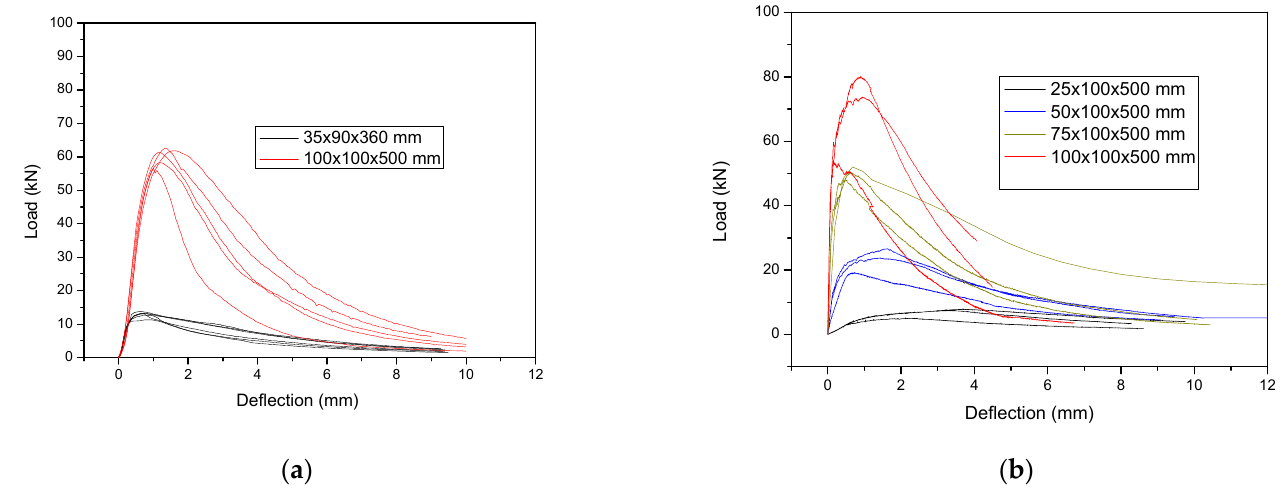
Figure 5. Load-deflection results for all the examined specimens of ( a ) UHPFRC-1 and ( b ) UHPFRC-2. The values of Figure 5 have been used for the calculation of the flexural strength for both UHPFRC-1 and UHPFRC-2.